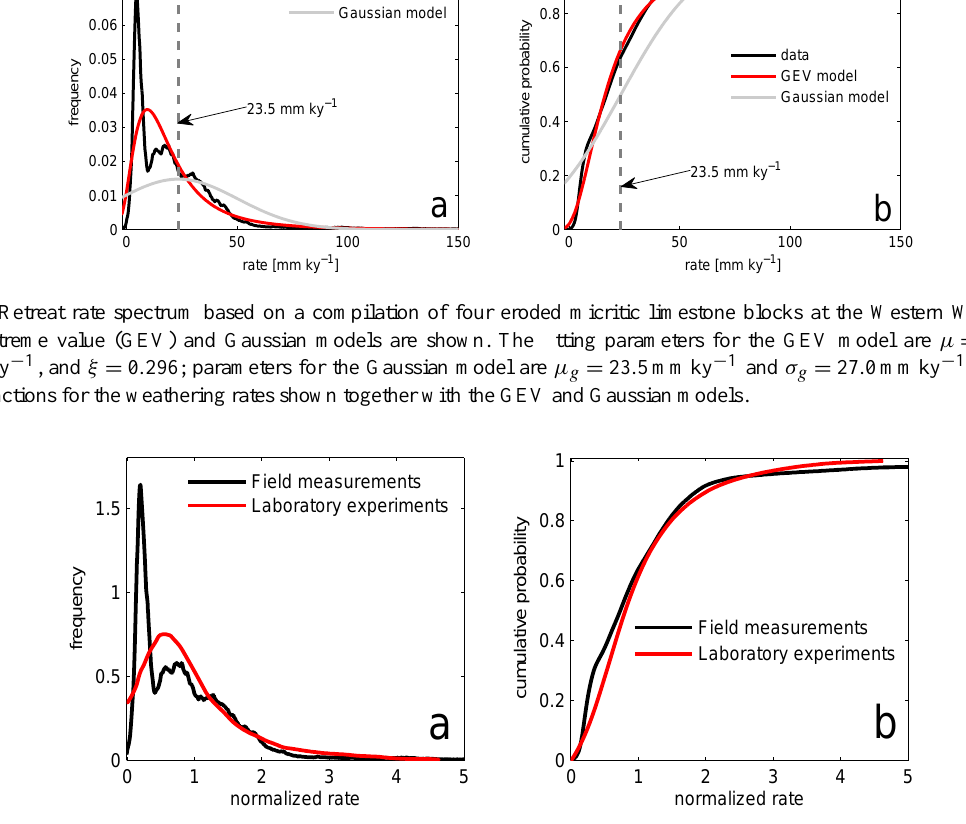
Figure 4. (a) Spectra of weathering rates of micritic limestone derived from field measurements and rates determined in laboratory exper- iments reported by Fischer et al. (2012). For each curve, the rates have been normalized to the mean rate in each data set. (b) Cumulative distribution functions for the two data